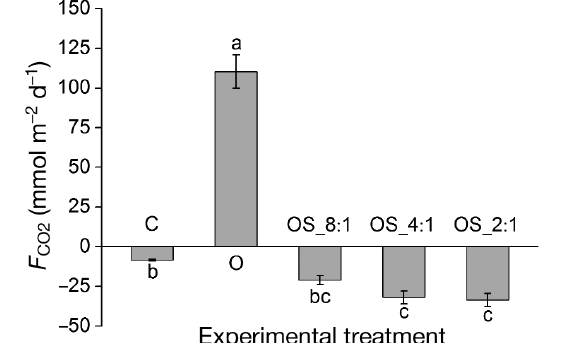
Fig. 6. Variations in air−sea CO 2 flux ( F CO2 ) among different experimental mesocosms. C: control; O: oyster only; OS_8:1, OS_4:1, and OS_2:1: oyster co-cultured with seaweed at ratios of 8:1, 4:1, and 2:1, respectively. Bars with different lower case letters are significantly different (ANOVA, p < 0.05)